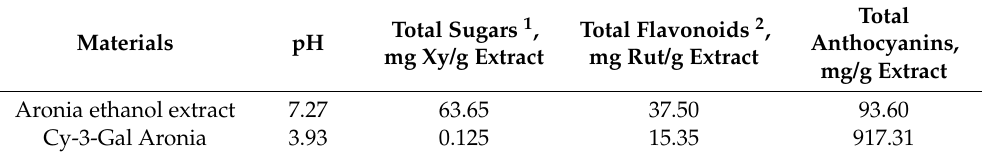
Table 1. Total content of sugars and natural antioxidants in ethanol extract and cyanidin-3-O- galactoside extract of Aronia melanocarpa berries (Cy-3-Gal Aronia) (on dry